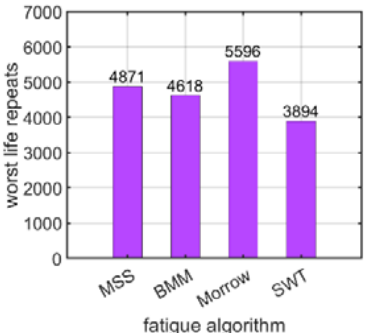
Figure 13. Number of logarithmic life repeats of the prestressed bolt with a nut connection for different fatigue